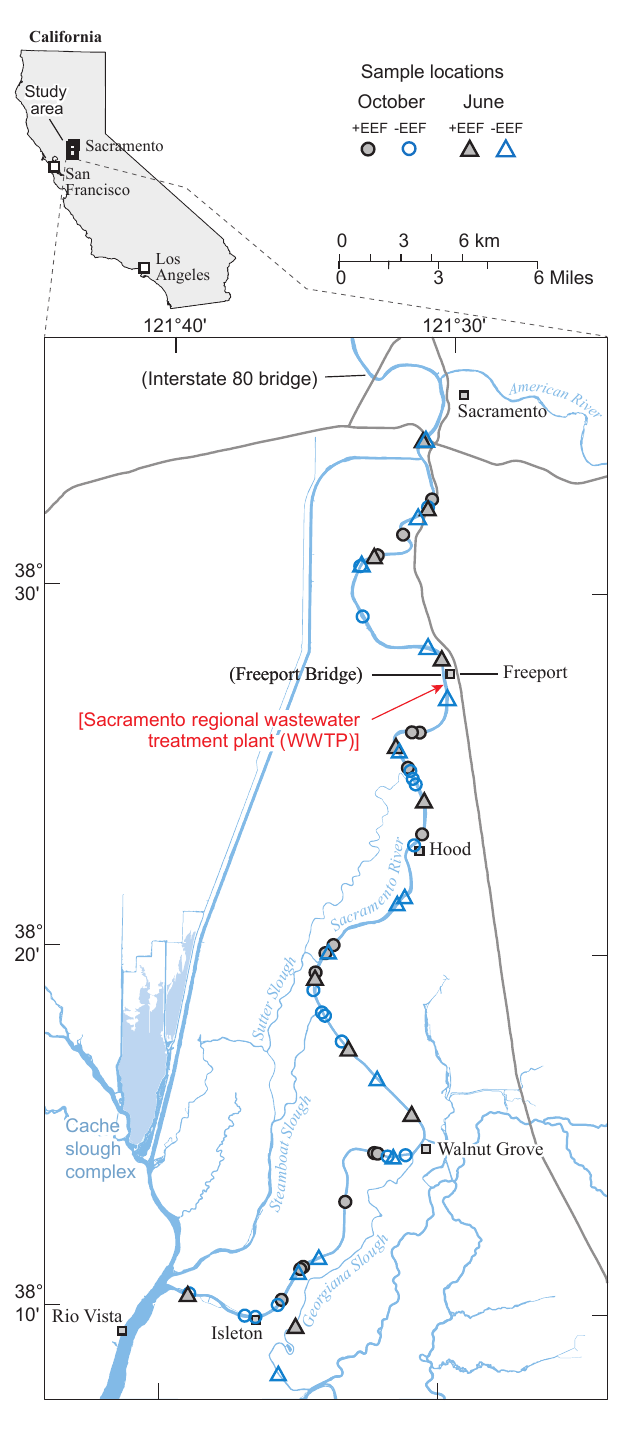
Figure 1. Map of the study reach on the lower 70km of the Sacra- mento River, California, showing the location where effluent from the Sacramento Regional Wastewater Treatment Plant (WWTP) en- ters the river and the locations of samples collected during the Oc- tober and June